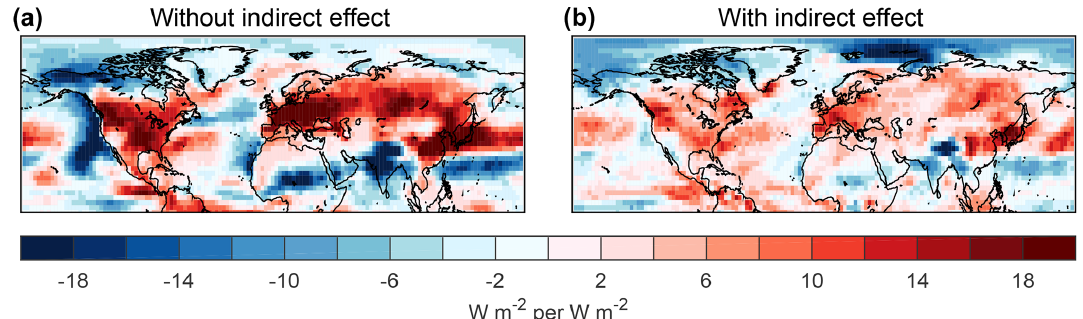
Figure 11. SWCRE changes in the BC experiment (a) for models without aerosol indirect effects and (b) for models with indirect